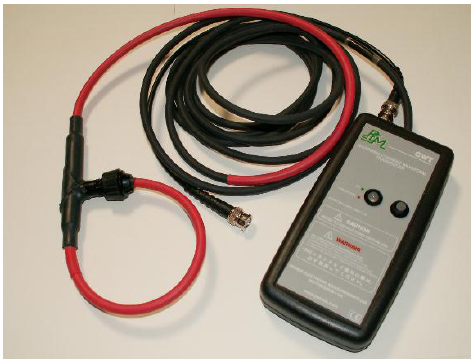
Figure 3. The electrical transducer (Rogowski coil and integrator device) used in the welding tests [14].